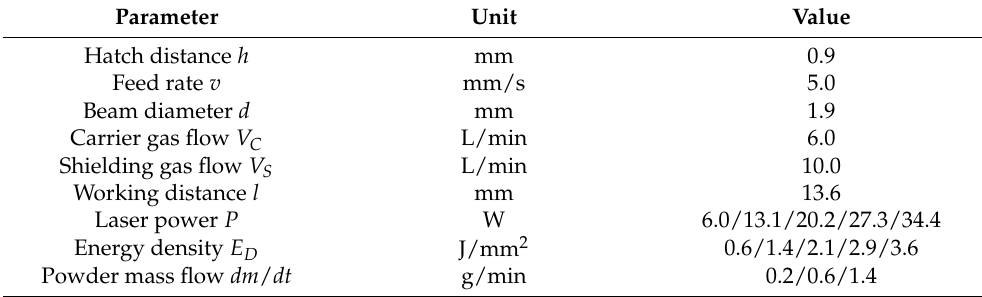
Table 1. Experimental design for the generation of PA12 coatings by DED-LB/P. Parameter Unit Value Hatch distance h mm 0.9 Feed rate v mm/s 5.0 Beam diameter d mm 1.9 Carrier gas flow V C L/min Shielding gas flow V